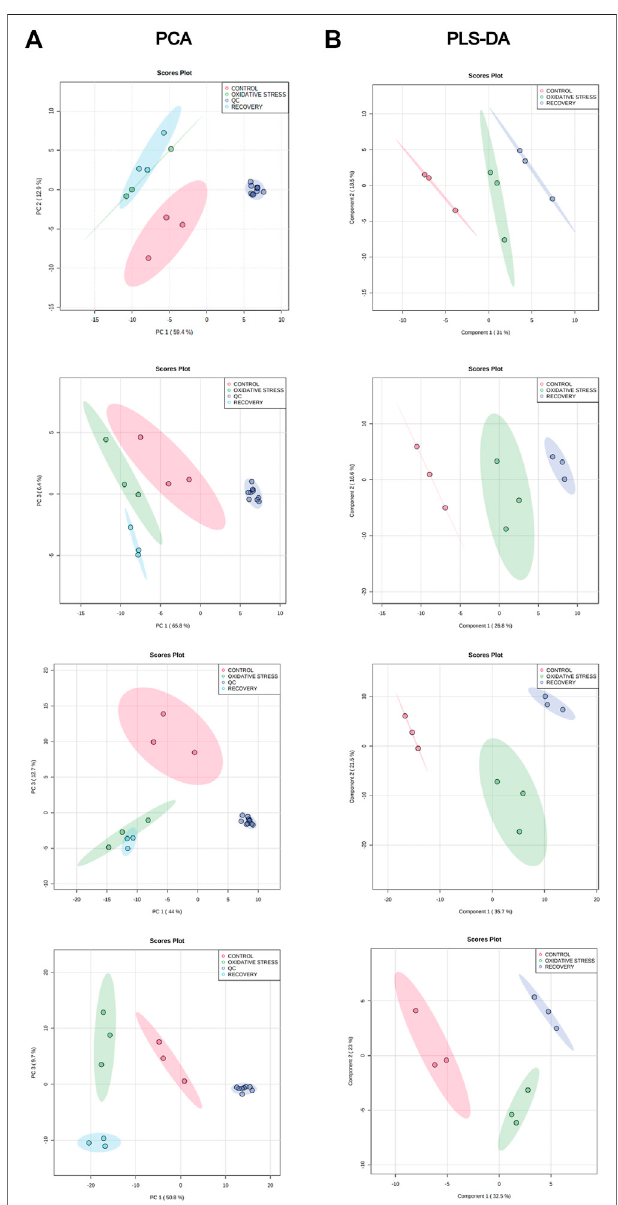
FIGURE 2 | (A) PCA for control (red), oxidative stress (green), recovery (light blue), and QCs (blue) samples for RPLC-ESI(+)-MS, RPLC-ESI( − )-MS, HILIC-ESI(+)-MS, and HILIC-ESI( − )-MS modes, from top to bottom. (B) PLS- DA score plot for control (red), oxidative stress (green), and recovery (blue) samples for RPLC-ESI(+)-MS, RPLC-ESI( − )-MS, HILIC-ESI(+)-MS, and HILIC-ESI( − )-MS modes, from top to bottom.